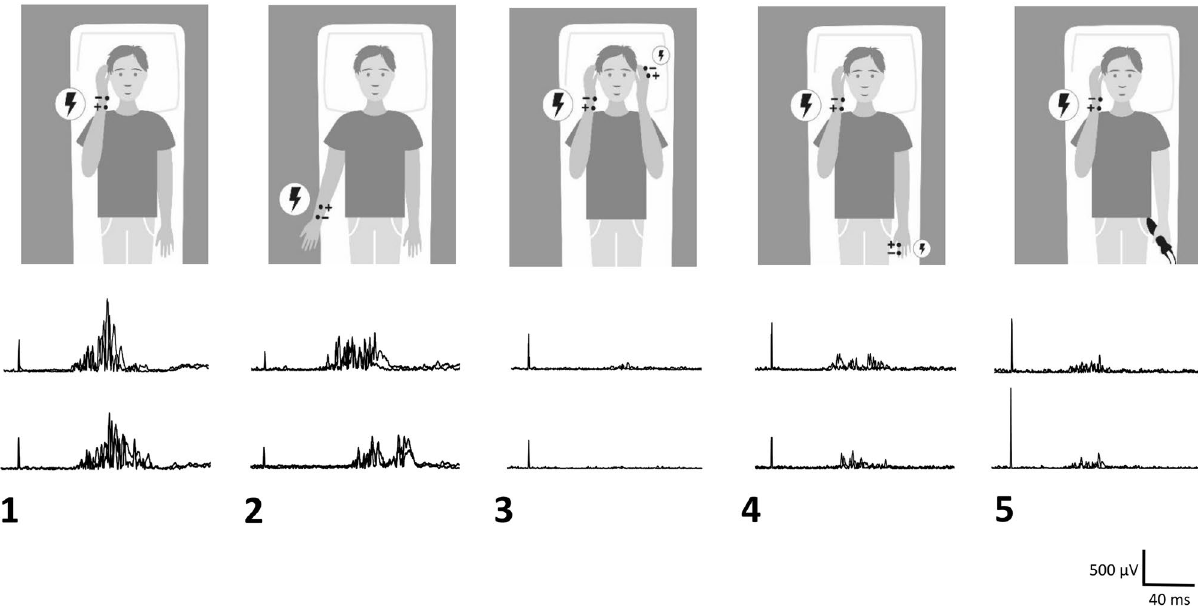
Figure 1. Representative examples of HBR recordings in a healthy participant in experimental conditions 1–5 . In conditions 1–4 , an experimenter triggers the stimuli; in condition 5 , the participant triggers stimuli herself. In condition 1 , the participant flexes the elbow and brings the dominant HBR-hand near to the face; the median nerve is stimulated at the wrist. In condition 2 , both arms are outstretched at the side of the participant’s body; the median nerve is stimulated at the wrist of the dominant HBR hand. In both conditions 1 and 2 , there is no prepulse, while in both conditions 3 and 4 , prepulses are delivered to the non-dominant index finger 100 ms preceding median nerve stimulation to the HBR-hand. In condition 3 , both HBR-hand and prepulse-hand are held close to the face. In condition 4 , the HBR-hand is held near to the face, while the non-dominant prepulse- hand is outstretched. In condition 5 , the HBR-hand is held near to the face, while the participant triggers with the non-dominant hand HBR-eliciting stimuli to the dominant median nerve (see text for more